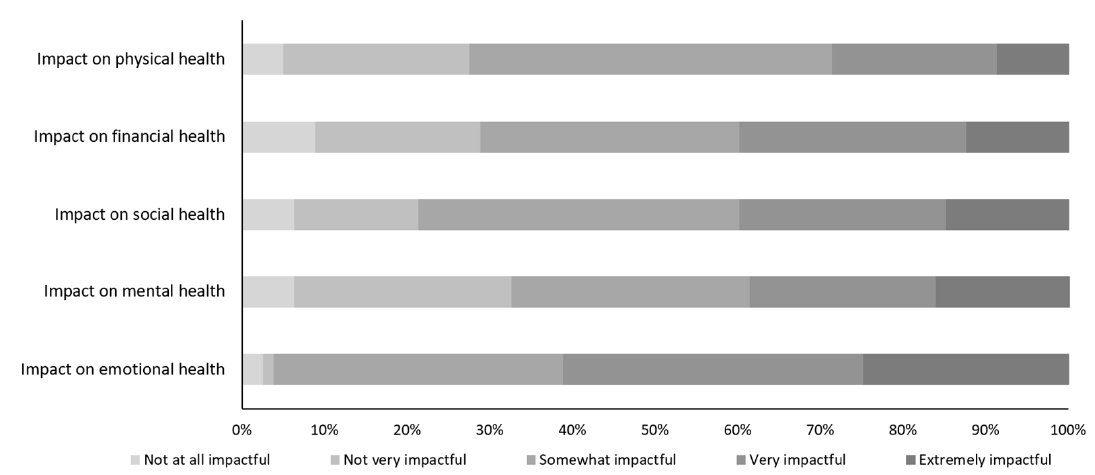
Figure 2. Impact of HD on care partners. Unadjusted data.